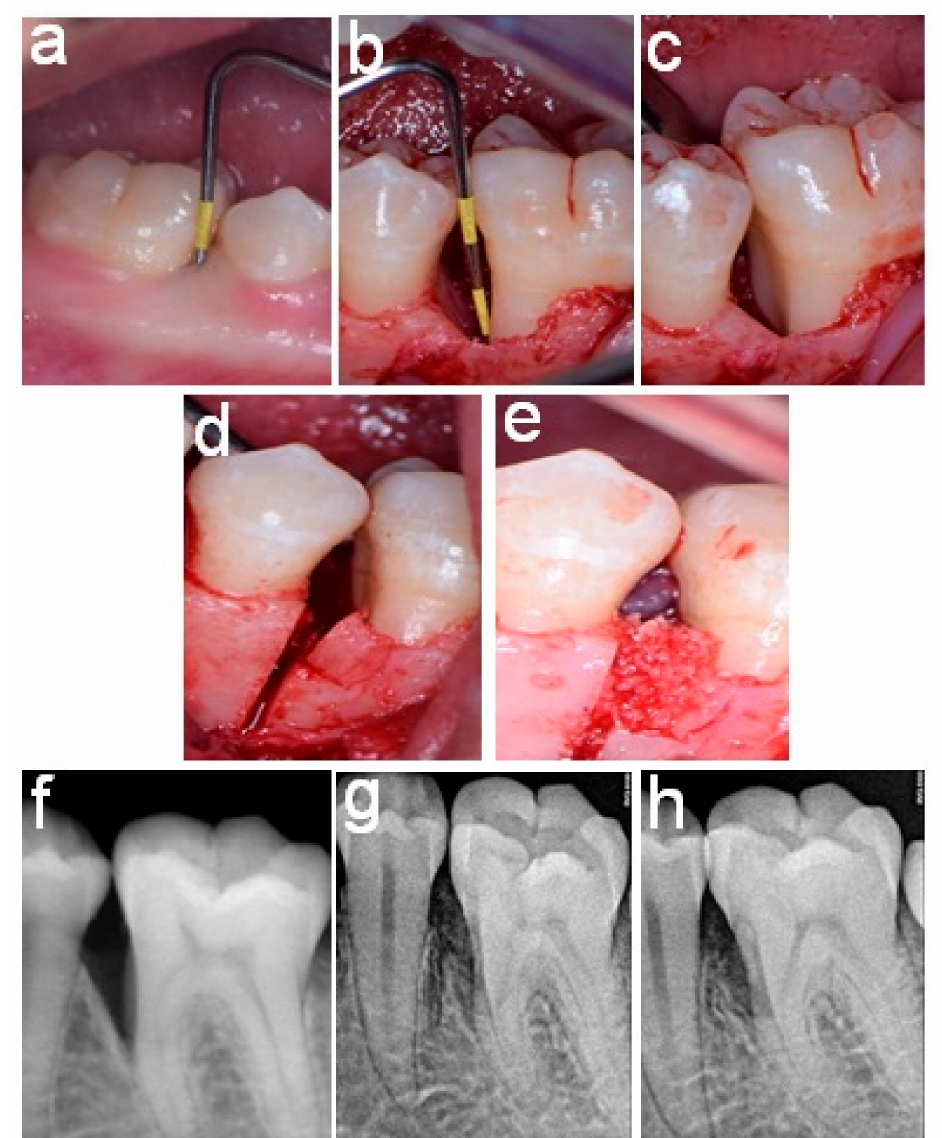
Figure 2. An 8-millimeter pocket related to the mesial surface of lower-left first molar of Group 1 patient. ( a ) Intra-bony defect of 5 mm, ( b , c ) osseous wall cutting and tilting, ( d , e ) grafting of the V-shaped space and ( f – h ) intra-oral radiograph obtained before, immediately after, and 6 months after